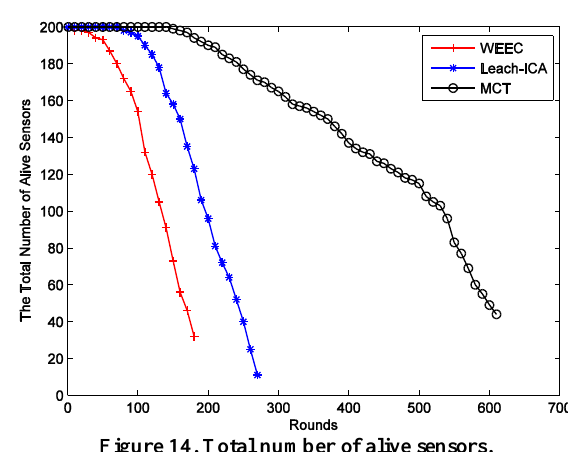
Figure 14. Total number of alive sensors.